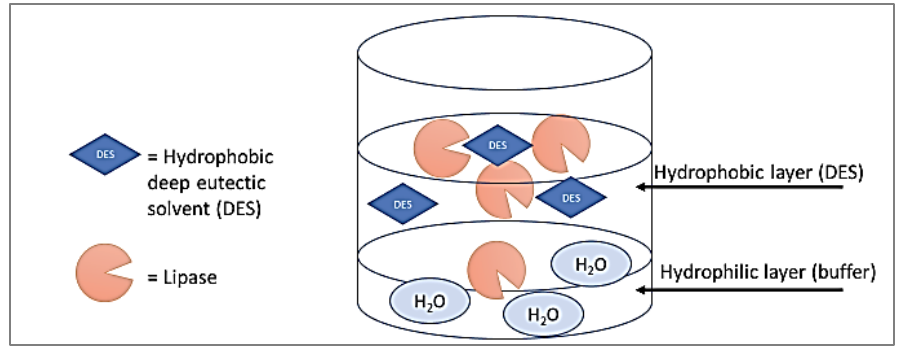
Figure 9. Illustration of lipase molecules’ predicted behavior in a medium containing a hydrophobic layer (DES) and a buffer solution (in water).